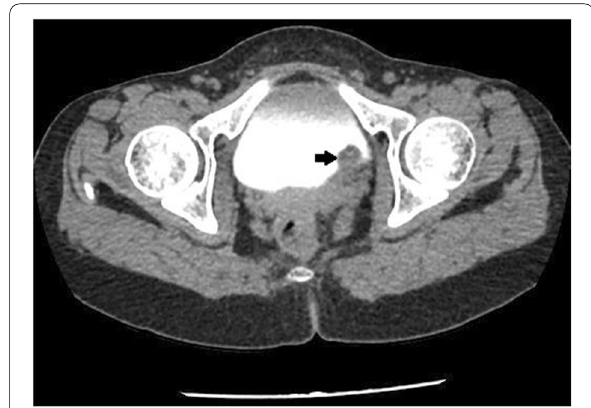
Fig. 2 Cystoscopic examination revealing a single polypoid mass of size approximately 3 This is a close view showing cystoscopic appearance of polypoidal